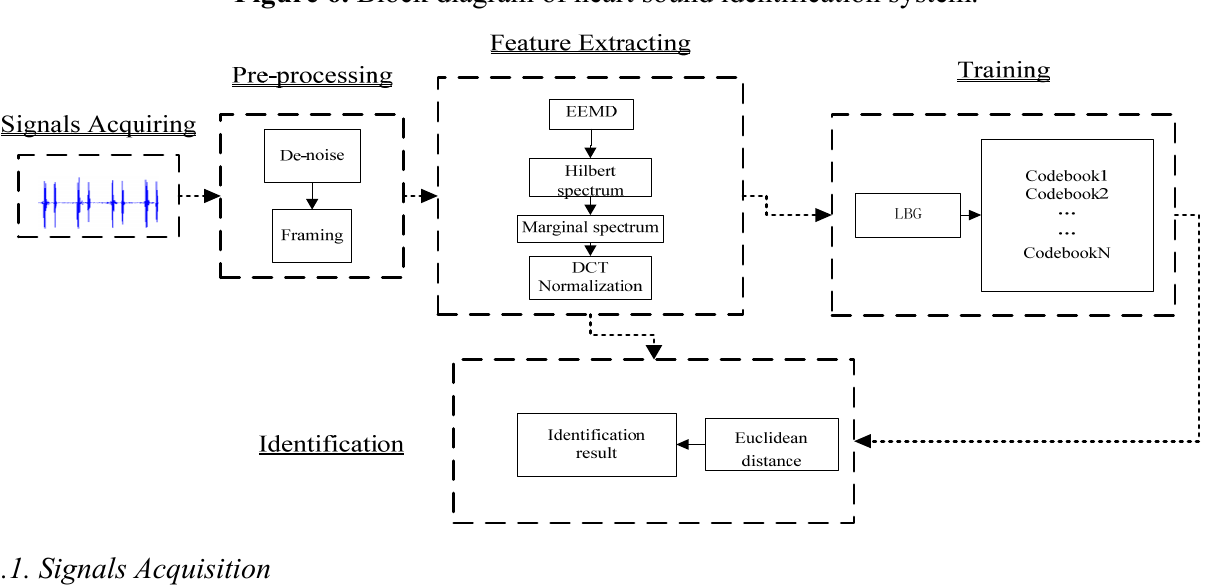
Figure 6. Block diagram of heart sound identification